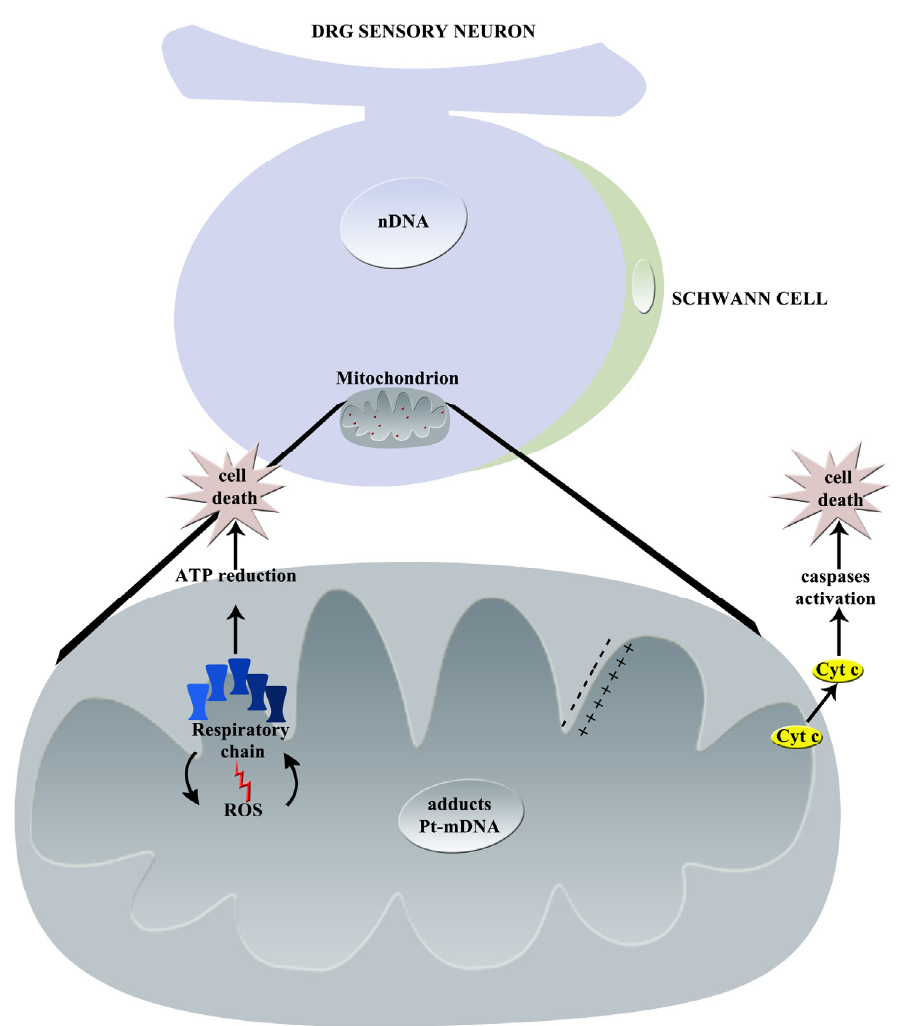
Figure 2. Graphical summary of cisplatin-induced mechanisms of neurotoxicity: principal effects on mitochondrion (nDNA = nuclear DNA, Pt = platinum, mDNA = mitochondrial DNA, Cyt c = Cytochrome C, ROS = Reactive Oxygen